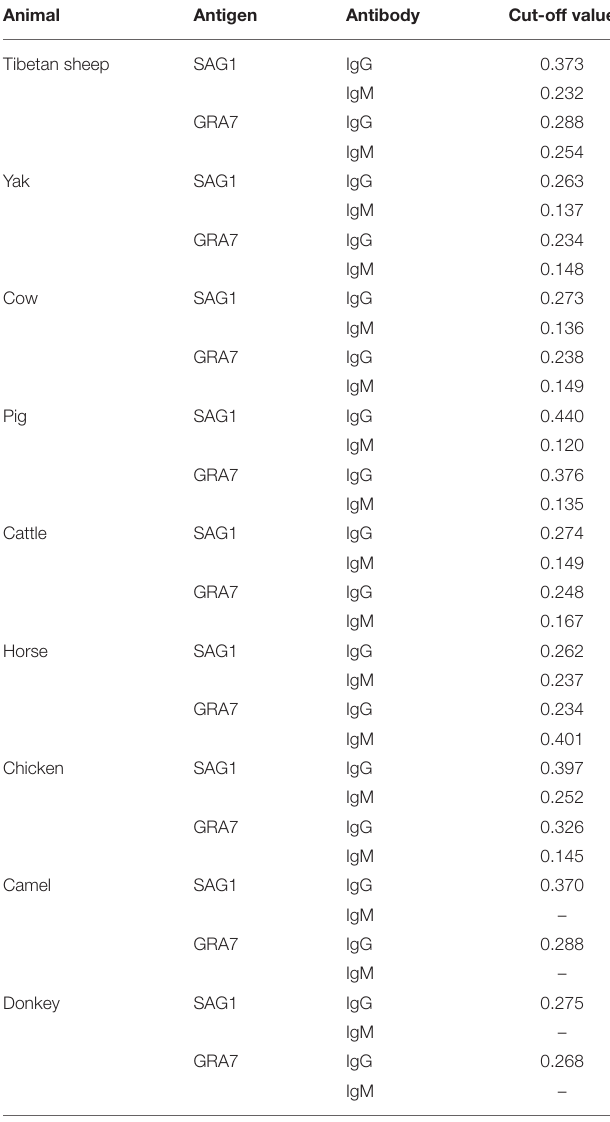
TABLE 2 | Cut-off values of current indirect ELISA tests in this study. Animal Antigen Antibody Cut-off